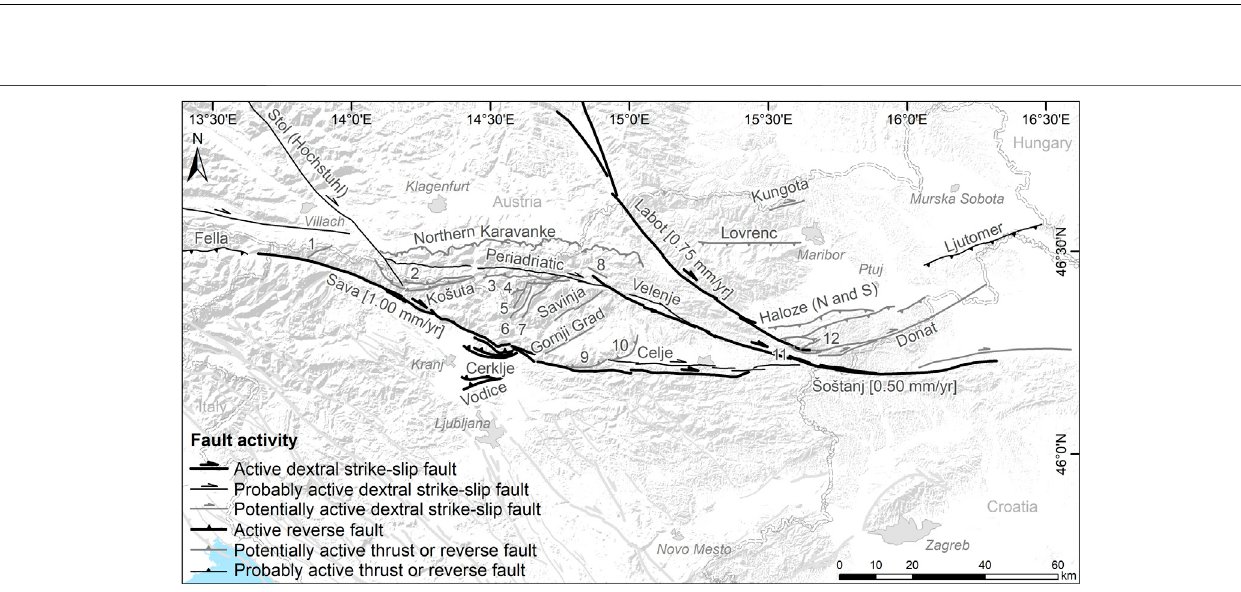
FIGURE9 | Faults ofthe Periadriatic fault system (PAFS), the Mid-Hungarianfault system (MHFS) and the Raba extensional fault system. Numbered faults include: 1 – Srednjivrhfault,2 – Zelenicafault,3 – Ol ˇ sevafault,4 – Podol ˇ sevafault,5 – MatkovKotfault,6 – Logarskadolinafault,7 – Studenecfault,8 – Javornikfault,9 – Menina fault, 10 – Vransko fault, 11 – Dravinja fault, 12 – Mlini ˇ s ˇ ce fault.